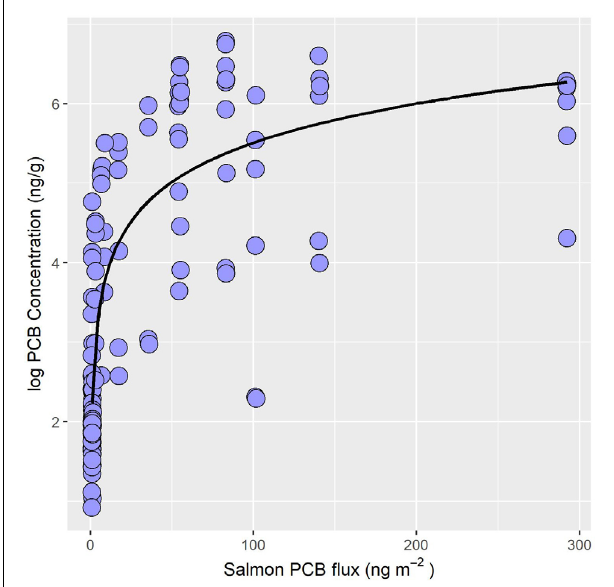
FIGURE 3 | PCB concentrations (ng/g wet weight) of stream-resident fish increase non-linearly with the flux of PCB (ng m − 2 ) supplied by salmon. Salmon PCB flux calculated from visual abundance estimates, biometric data, and mean PCB burden of salmon. Data source: Gerig, 2017.